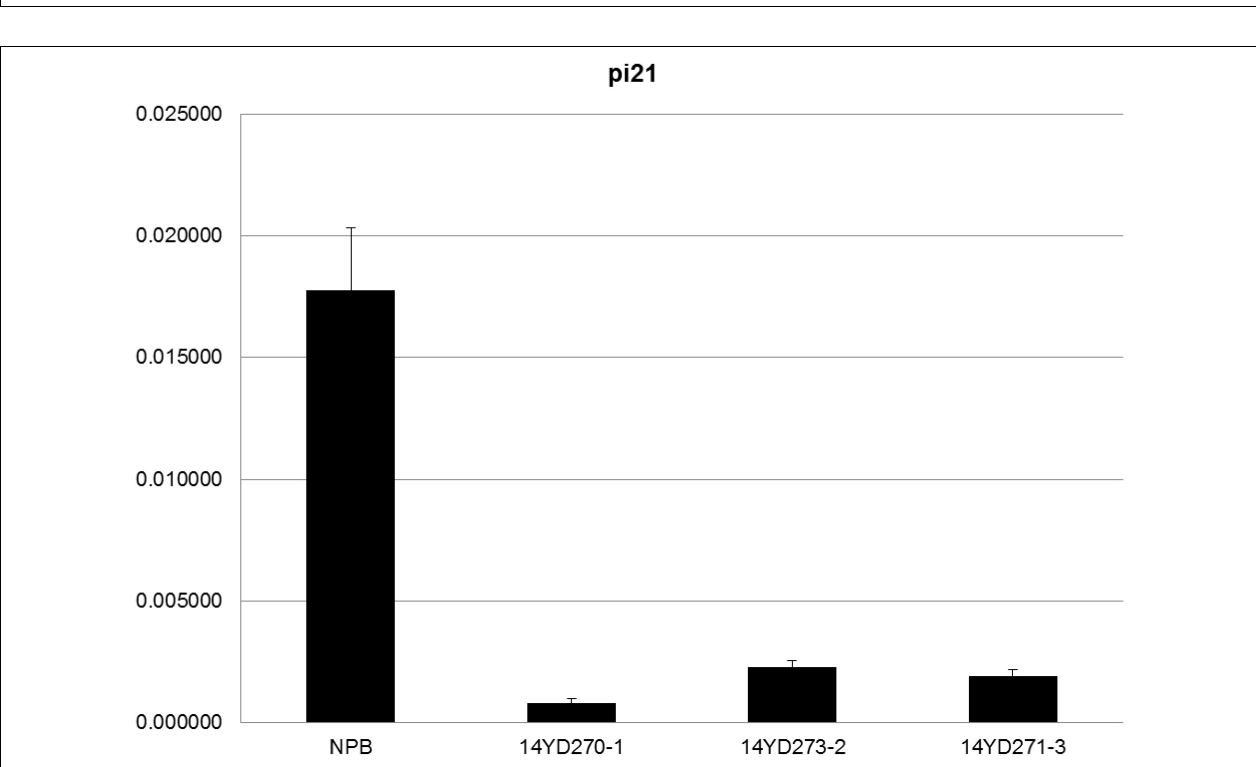
FIGURE 4 | Southern analysis of pBDL23-transformed marker-free T2 plants. Wild-type rice (NPB) was used as a control. (A) Southern hybridization using the Ds probe. (B) Southern hybridization using the HPT probe. (C) Southern hybridization using the GFP probe.